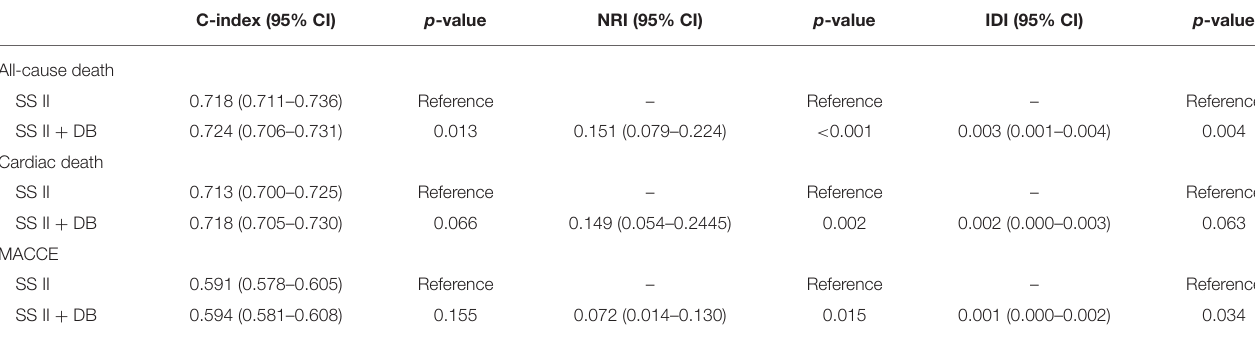
TABLE 6 | Additional predictive value provided by DB beyond the SS